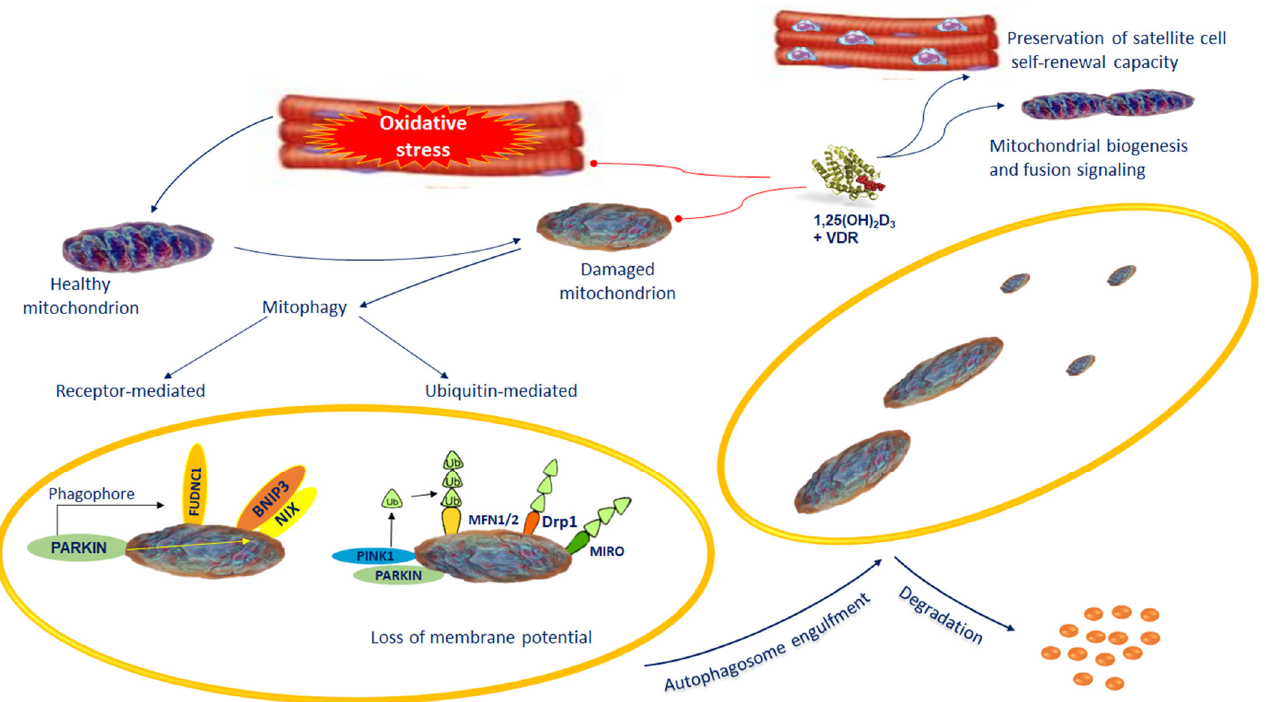
Figure 2. Dysfunctional or impaired mitochondria are removed from the cell via mitophagy. Defective mitochondria are loaded into the autophagosomes followed by lysosomal degradation. Mitophagy takes place by selective autophagy of mitochondria via receptor ‐ mediated mitophagy or ubiquitin ‐ mediated mitophagy. The mitophagy receptors participating in the selective clearance of mitochondria include BNIP3/NIX and FUDNC1 and the PINK1/Parkin pathway. The preservation of the normal mitochondrial control is one of the most important actions of vitamin D. During muscle regeneration, 1,25(OH)2D3 stimulates an increase in VDR levels in satellite cells and central myonuclei. This process subsidizes the preservation of satellite cell self ‐ renewal capacity. VDR increases mitochondrial biogenesis and fusion signaling, and inhibiting ROS production mitigates antioxidant demand, which promotes regenerative phenotype. Abbreviations: BNIP3/NIX: BCL2 interacting ‐ protein ‐ 3 ‐ like; FUNDC1 = FUN14 domain ‐ containing 1; 1,25(OH) 2 D3 = 1,25 ‐ dihydroxyvitamin D3; MFN 1/2 = Mitofusin 1/2; Parkin = Parkinson protein 2, E3 ubiquitin protein ligase ; PINK1 = PTEN ‐ induced putative kinase protein ‐ 1; RHOT1/MIRO: Ras homolog family member T; VDR = Vitamin D receptor.